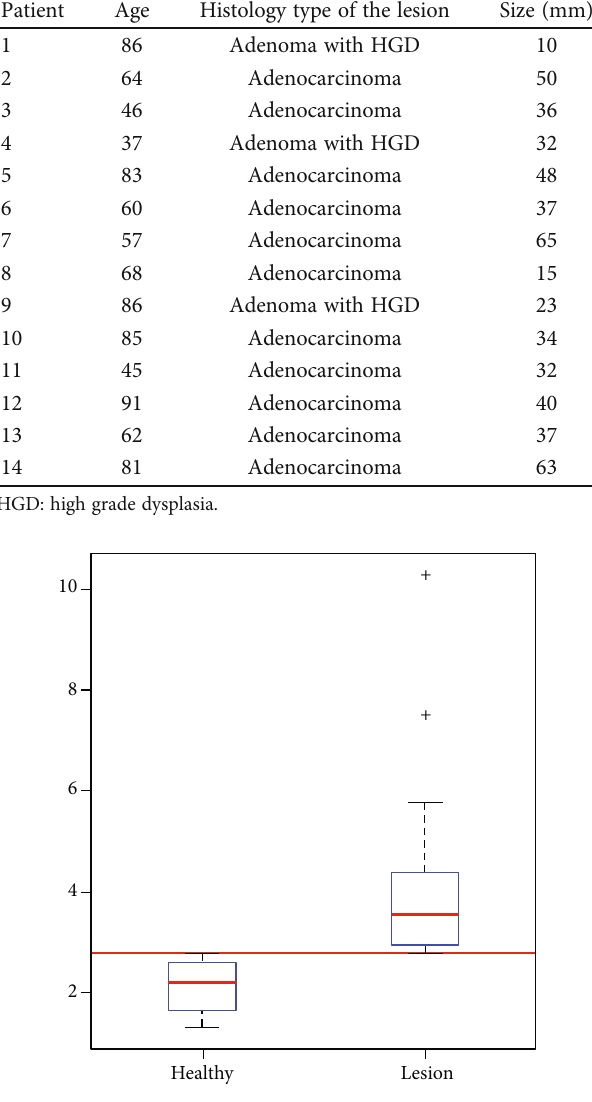
Figure 3: Reconstructed maximum dielectric property contrast of each patient and frame obtained with microwave-based colonoscopy for healthy mucosa areas and for lesions. The detection threshold fi xed to 2.79 is represented as a horizontal red line. All values above the line are classi fi ed as lesion and below as healthy